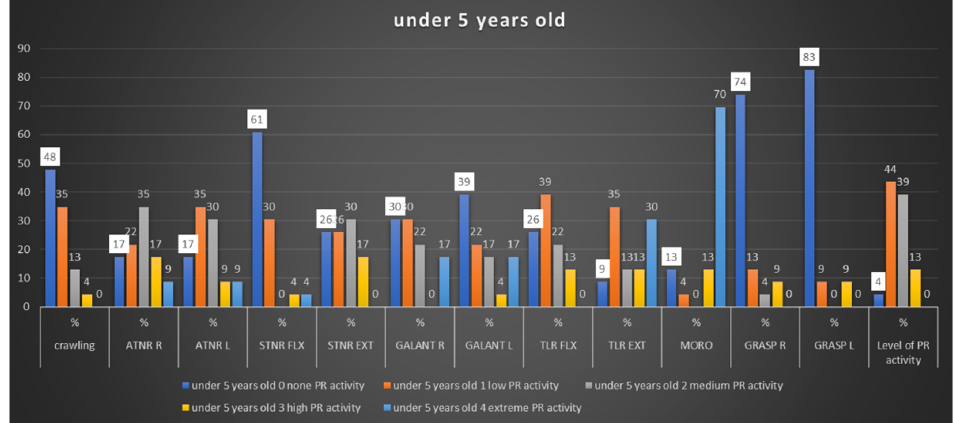
Figure 3. The scale of primitive reflexes (PRs) activity in younger children. Percentage of crawling pattern performance and the reflexes activity.